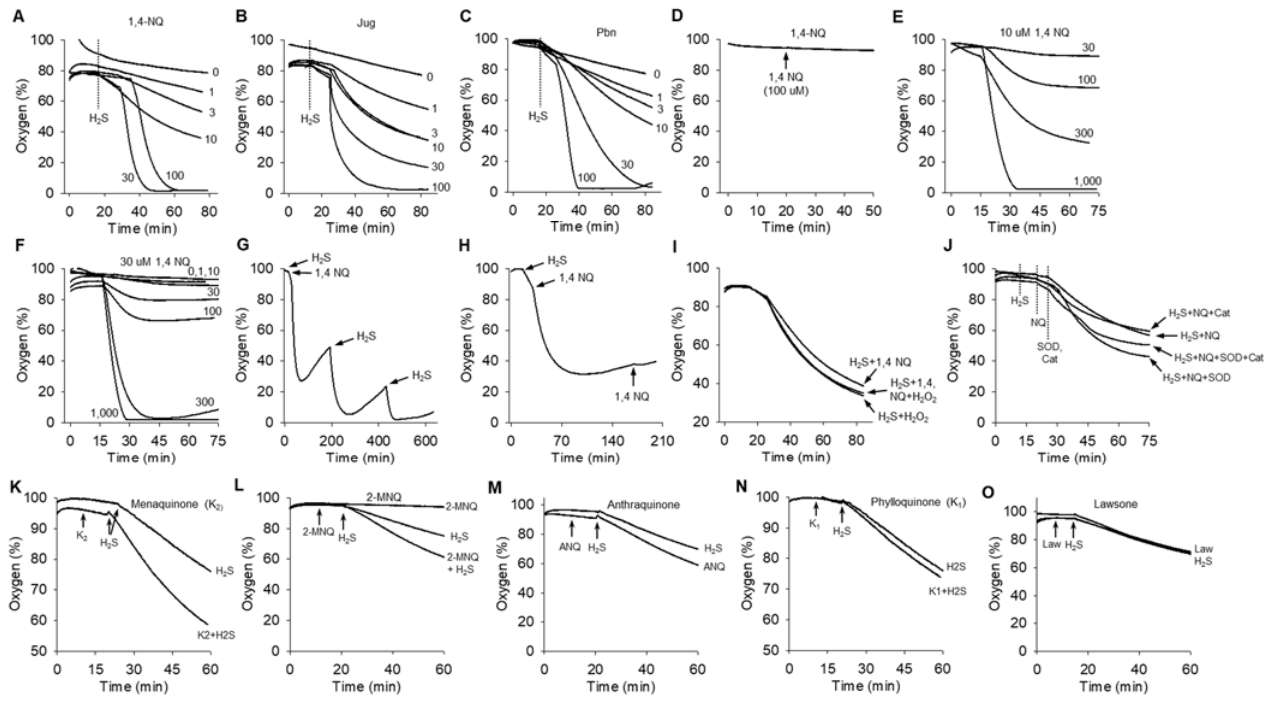
Figure 5. Typical real ‐ time traces of O 2 consumption by naphthoquinones under various conditions. ( A – C ) O 2 is concentration ‐ dependently consumed during incubation of 300 μ M H 2 S with increasing concentrations of ( A ) 1,4 ‐ naphthoquinone (1,4 ‐ NQ), ( B ) juglone (Jug) or ( C ) plumbagin (Pbn). ( D ) 100 μ M 1,4 ‐ NQ does not consume O 2 in the absence of H 2 S. ( E , F ) H 2 S concentration ‐ dependently increases O 2 consumption by 10 μ M ( E ) and 30 μ M ( F ) 1,4 ‐ NQ. ( G , H ) O 2 levels begin to rise after prolonged incubation of 30 μ M 1,4 ‐ NQ with 300 μ M H 2 S and they are decreased upon subsequent addition of H 2 S ( G ) but not by 1,4 ‐ NQ ( H ). ( I ) H 2 O 2 (100 μ M) does not affect O 2 consumption in the